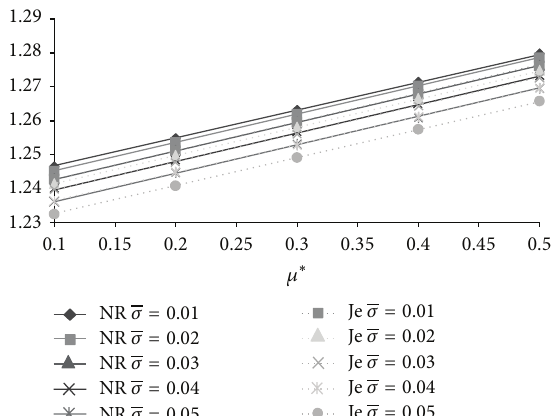
Figure 4: Variation of load carrying capacity with respect to 𝜇 ∗ and 𝜀 .